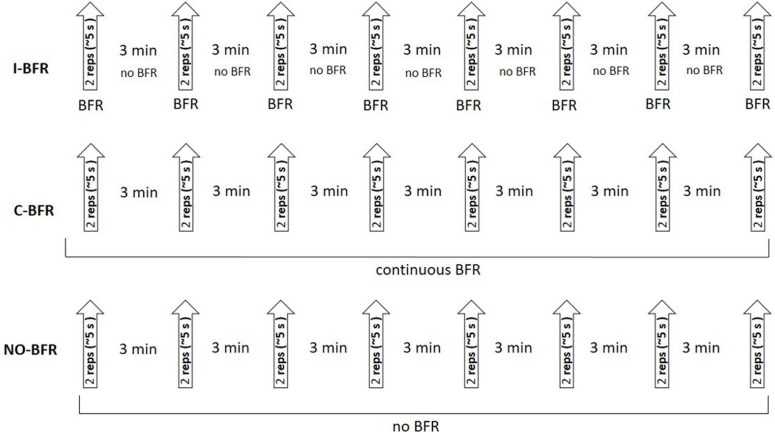
Schematic representation of the experimental protocol. I-BFR, intermittent blood flow restriction; C-BFR, continuous blood flow restriction; NO-BFR, no blood flow restriction (control condition).